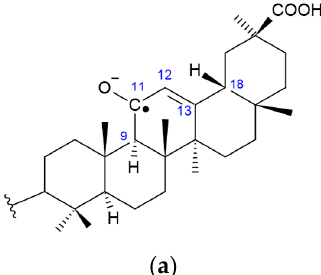
Figure 4. Two possible paramagnetic forms of GL. The glucuronide fragment of GL is omitted in the figure. ( a ) The radical anion of GL (R1), ( b ) ketyl ‐ type radical of GL (R2).